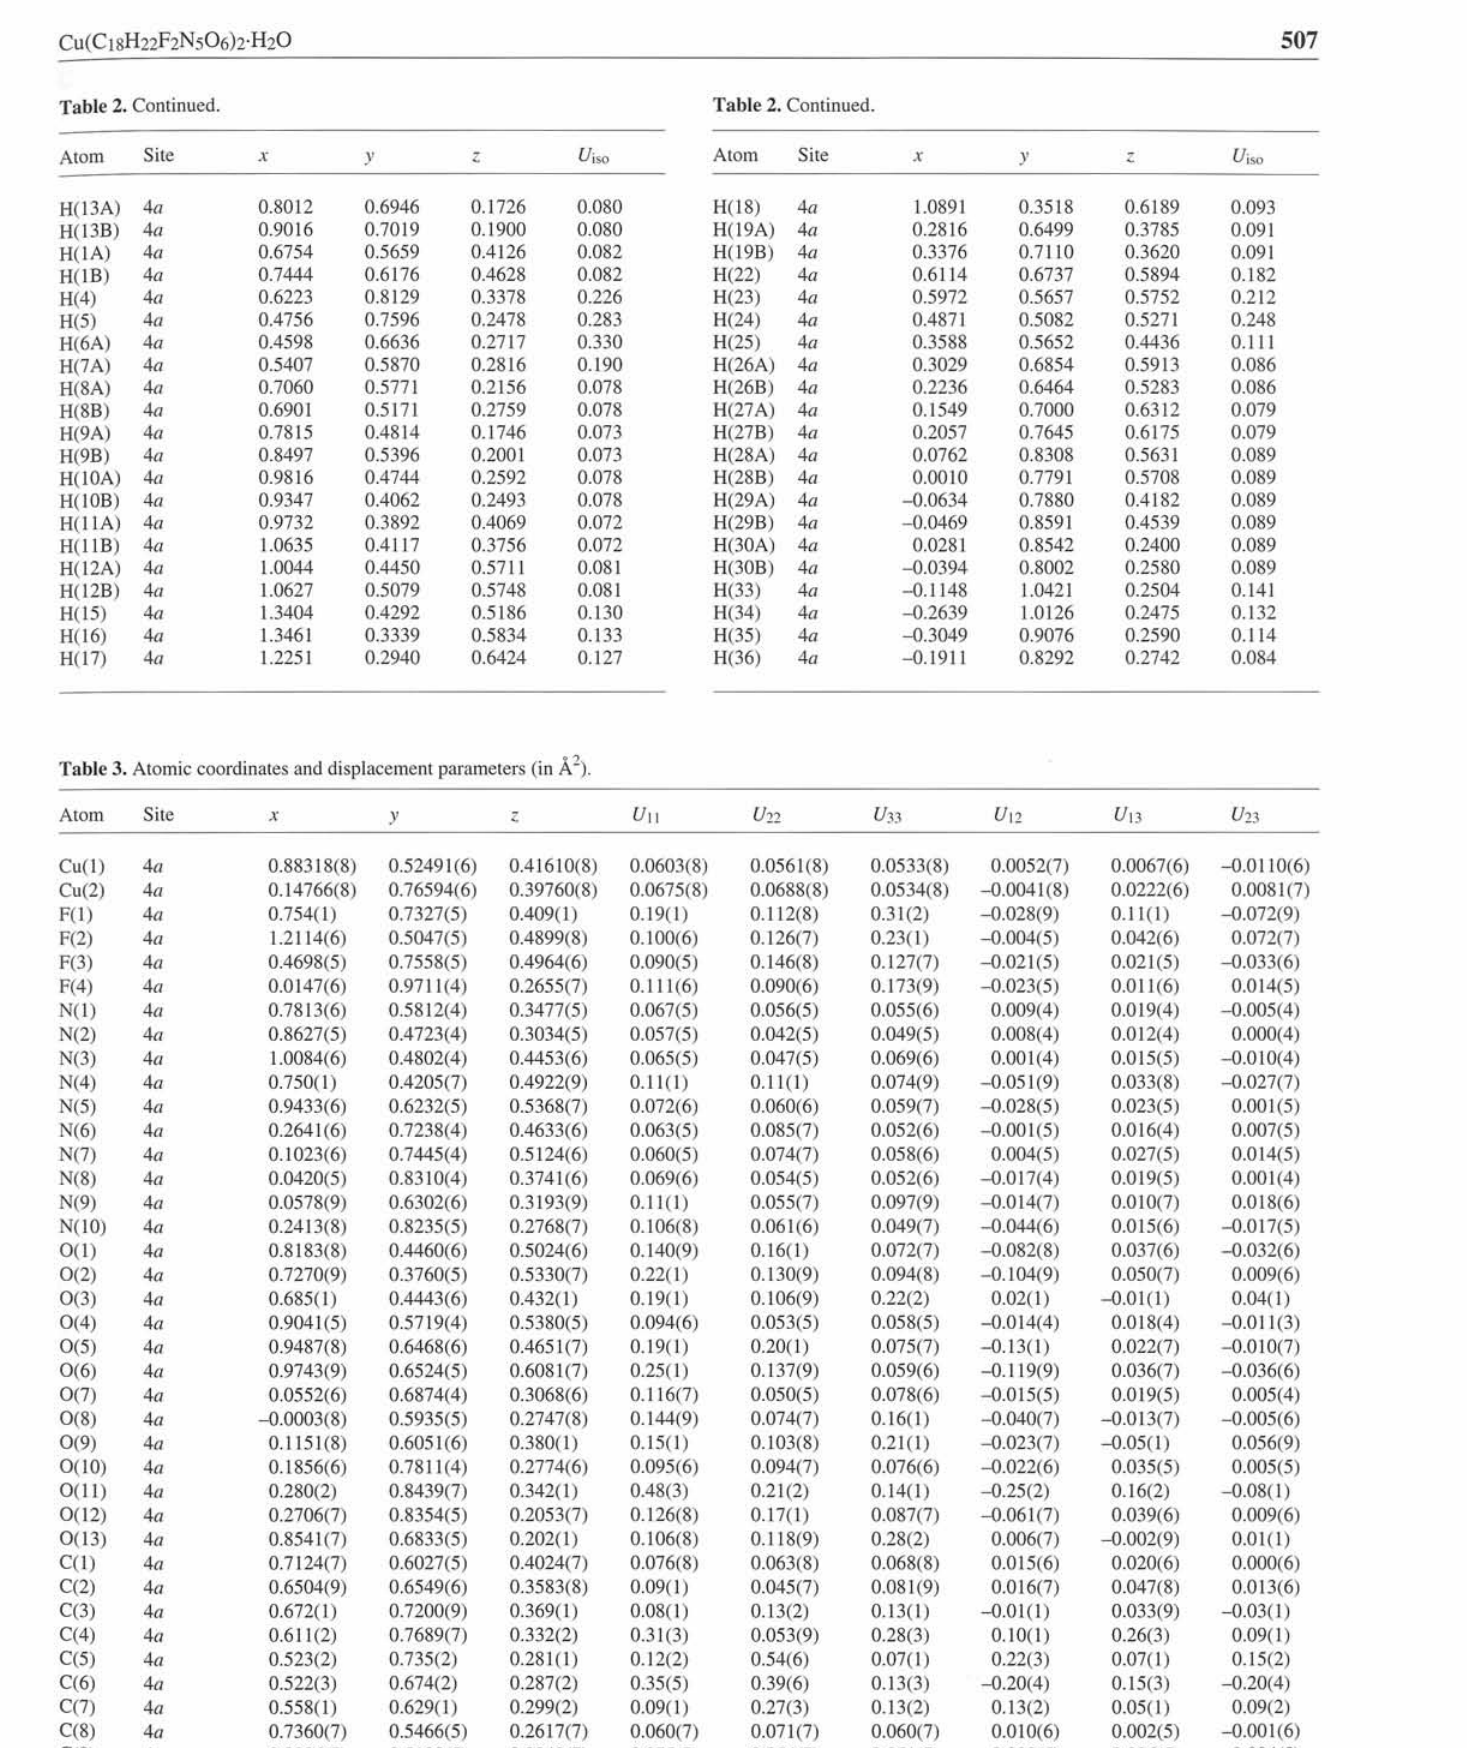
Table 3. Atomic coordinates and displacement parameters (in Â 2